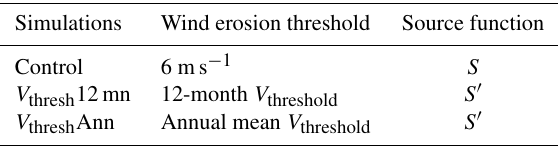
Table 4. Simulation design.